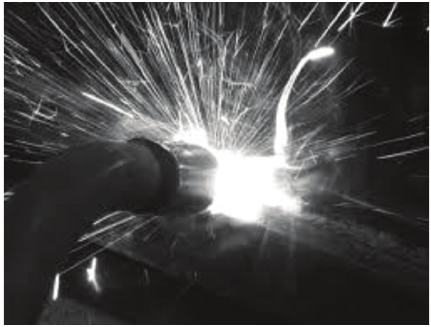
Figure 2: Opening for electric arc welding